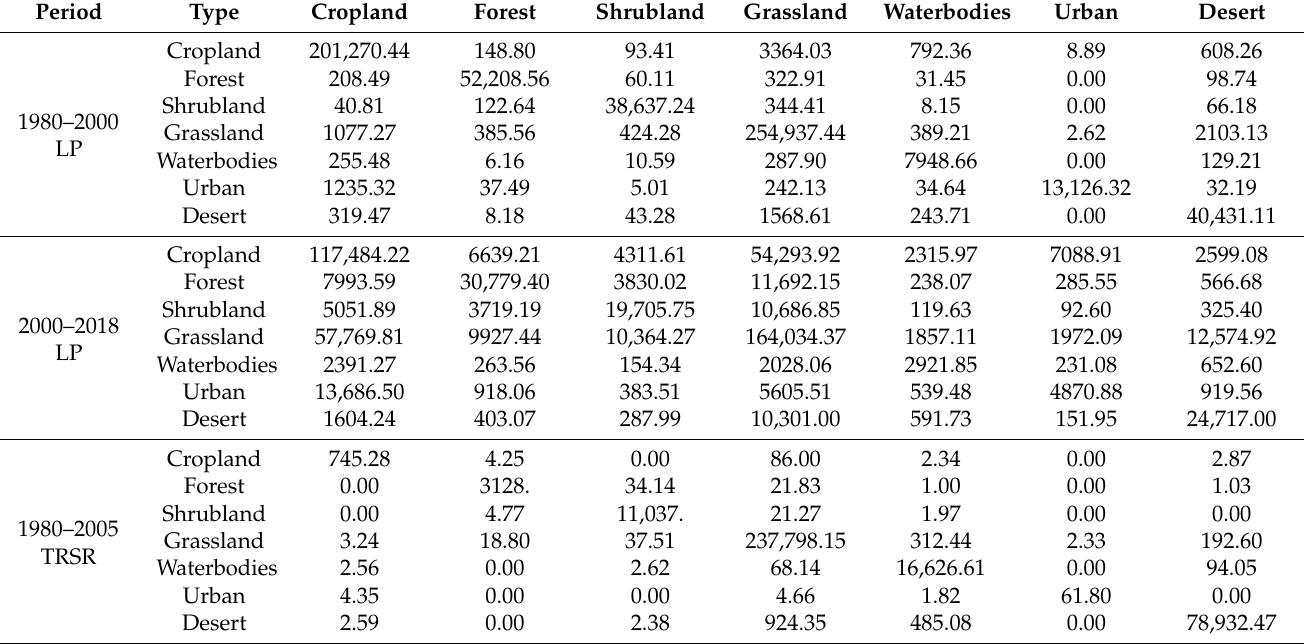
Table 4. Transfer matrix of different land cover types from 1980 to 2018 in the study regions (unit: km 2